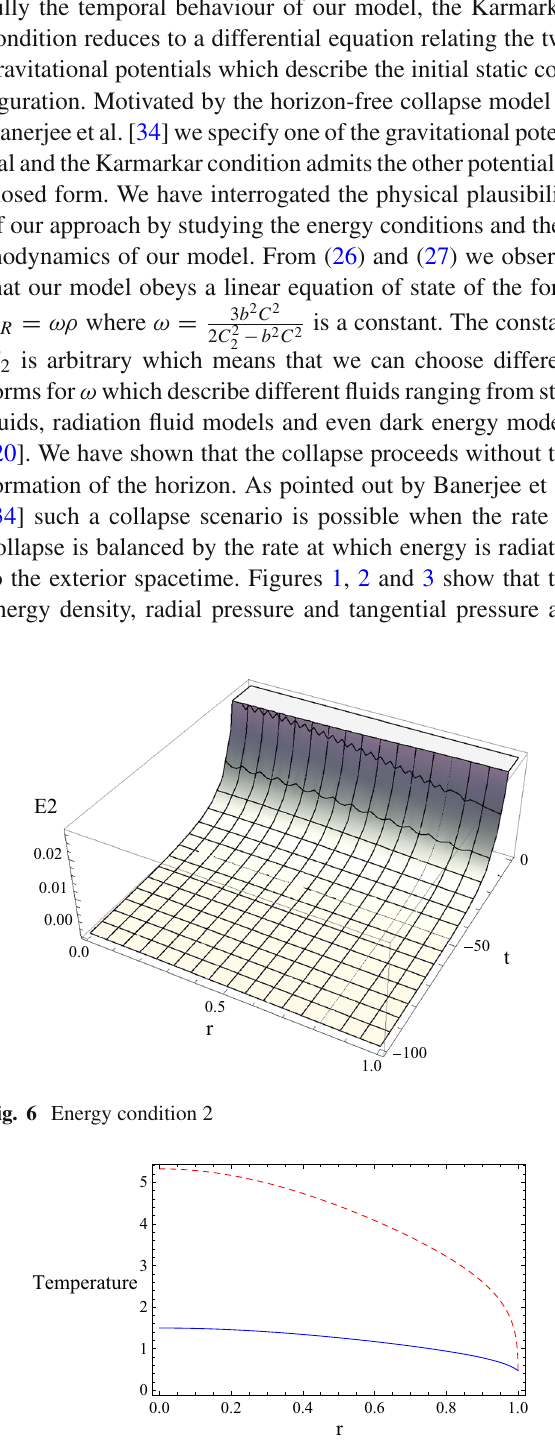
Fig. 7 Causal(dashedline)andnoncausal(solidline)temperaturepro-